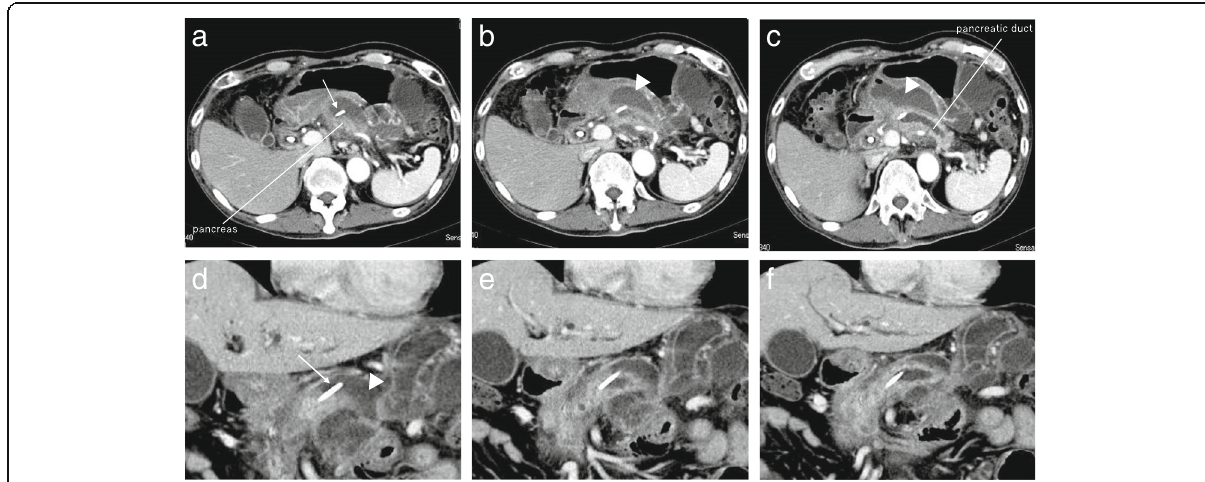
Fig. 1 Enhanced computed tomography of the abdomen. A pancreatic stent protruded from the pancreatic body (arrow), and there was fluid collection around the greater omentum (arrowhead). a – c Axial view. d – f Coronal